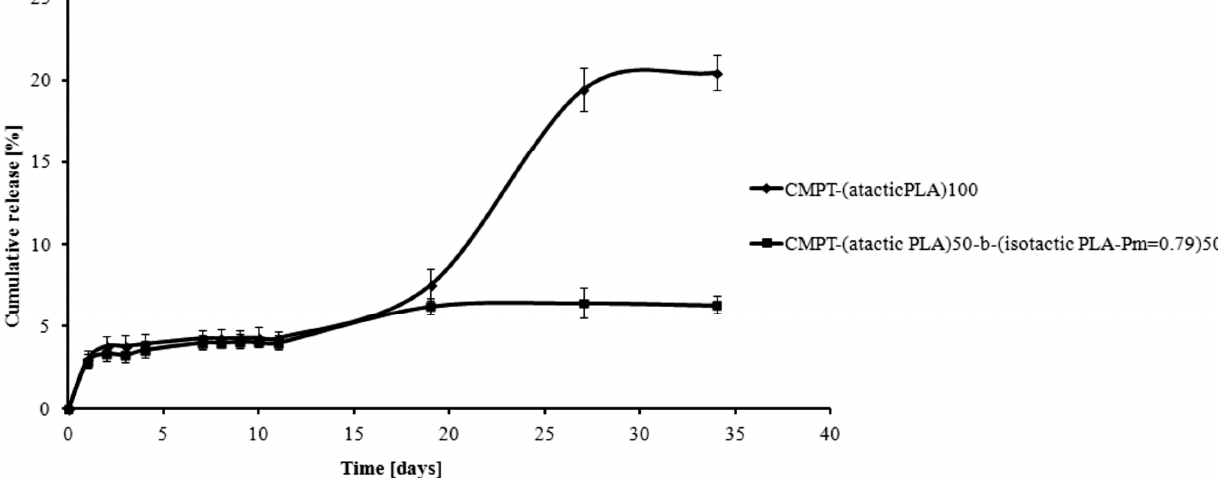
Figure 2. Release of CMPT from the CMPT-PLA conjugates at pH 1.